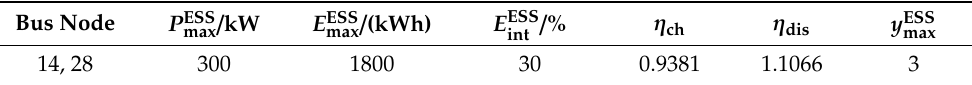
Table 2. Parameters ofenergy storage system.